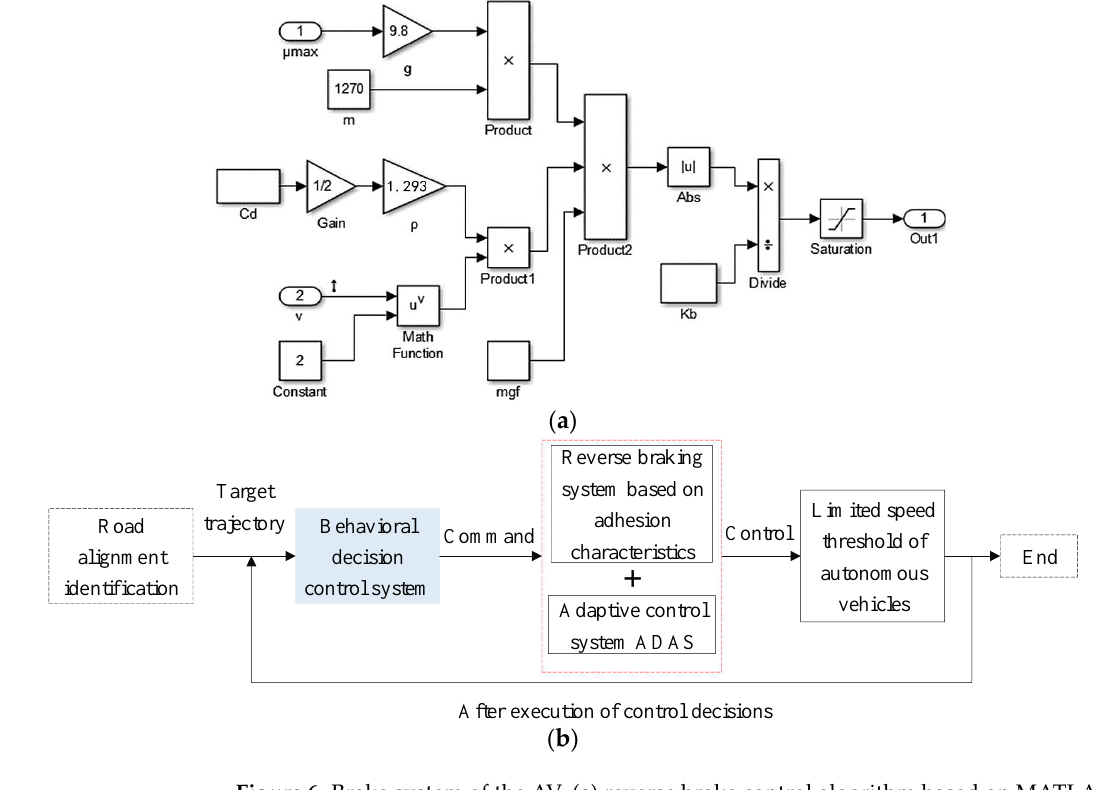
Figure 6. Brake system of the AV: ( a ) reverse brake control algorithm based on MATLAB/Simulink; ( b ) schematic diagram for the steering braking control system.